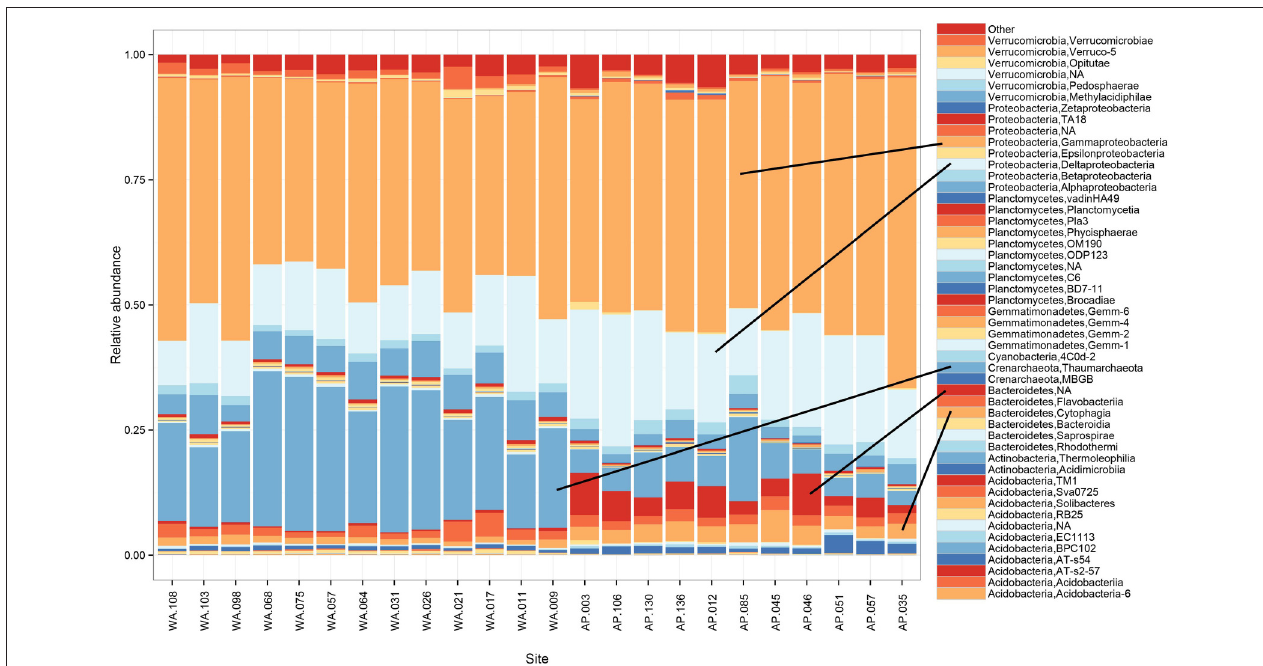
FIGURE 4 | Taxonomic composition and relative abundance of 16S rRNA sequences based on the class breakdown of the bacterial and archaea phyla that appeared at ≥ 1% relative abundance in any of the